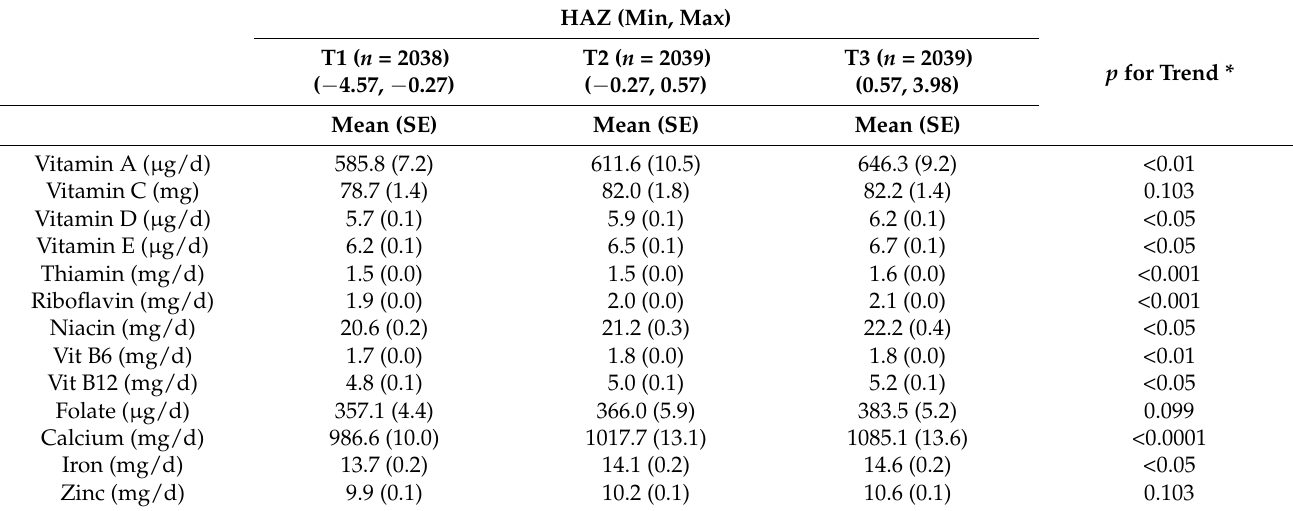
Table 2. Daily average micronutrient intakes by tertile of HAZ among US children aged 2–18 years in NHANES 2007–2014 ( n = 6116).